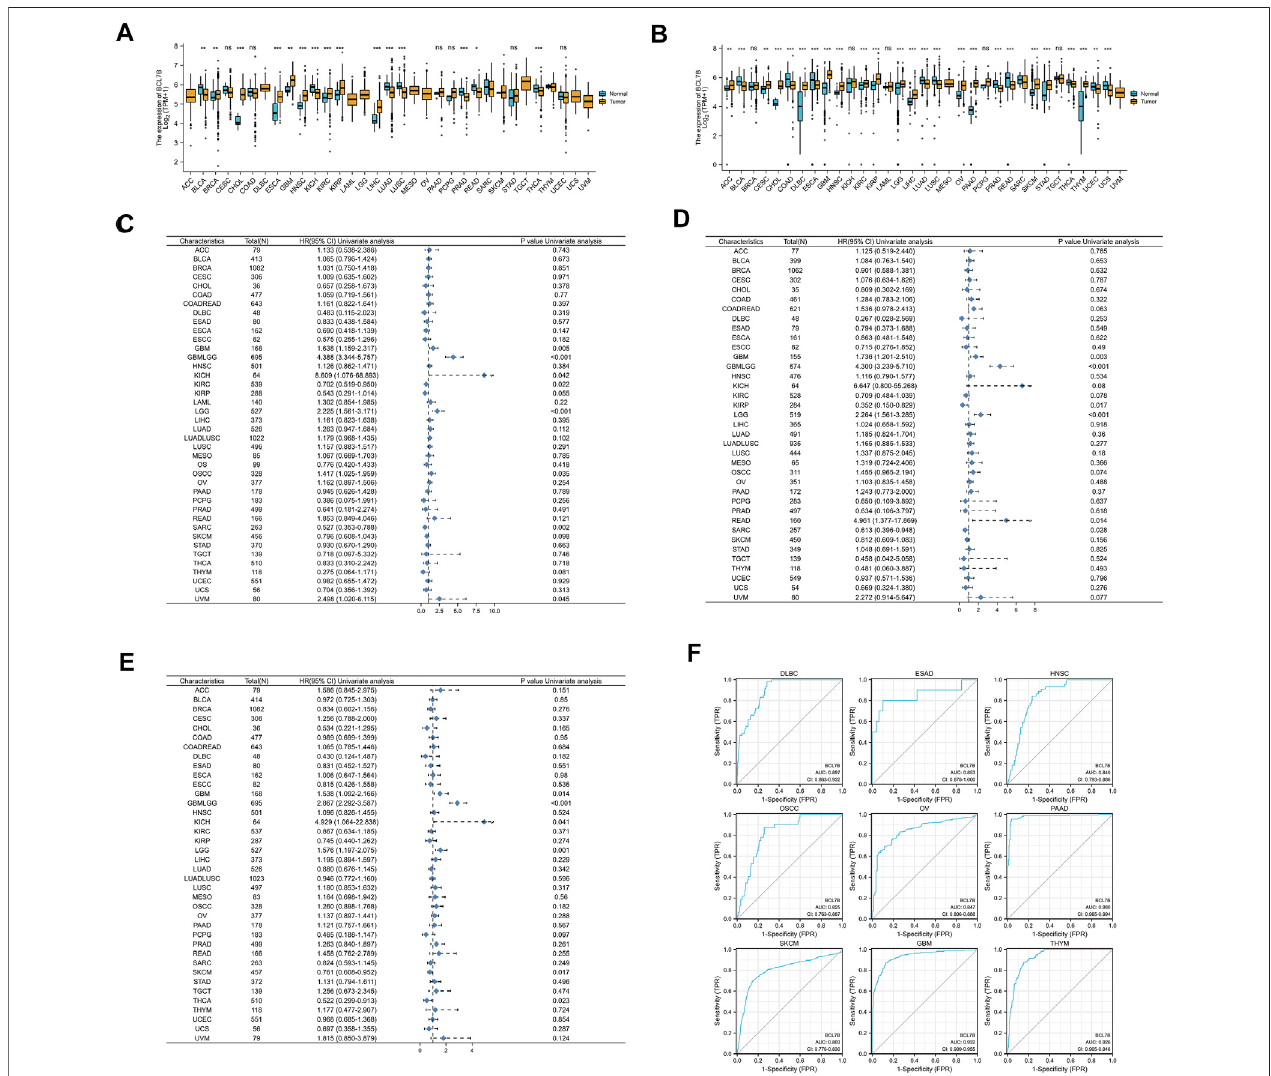
FIGURE 1 | Expression of BCL7B gene, and prognostic and diagnostic value in pan-cancer. (A) Expression of BCL7B gene in 33 types of cancers based on the data from TCGA database. (B) Expressionof BCL7B gene in33 types of cancers based on the datafrom TCGA and GTEx databases. (C) OS showed that BCL7B was notably correlated with the prognosis of GBM ( p = 0.014), GBMLGG ( p < 0.001), KICH ( p = 0.041), KIRC ( p = 0.022), LGG ( p = 0.001), OSCC ( p = 0.035), SARC ( p = 0.002), and UVM ( p = 0.045). (D) DSS displayed that BCL7B is markedly related with the prognosis of GBM ( p = 0.003), GBMLGG ( p < 0.001), KIRP ( p = 0.017), LGG ( p < 0.001), READ ( p = 0.014), and SARC ( p = 0.028). (E) PFI re fl ected that BCL7B was dramatically correlated with the prognosis of GBM ( p = 0.014), GBMLGG ( p < 0.001), KICH( p =0.041),LGG( p =0.001), SKCM( p =0.017), andTHCA ( p =0.023). (F) ROCcurvesshowedthat BCL7B had ahigh diagnostic value(AUC > 0.8) in DLBC, ESAD, HNSC, OSCC, OV, PAAD, SKCM, GBM, and THYM. p p < 0.05, pp p < 0.01, ppp p < 0.001, and ns, p ≥